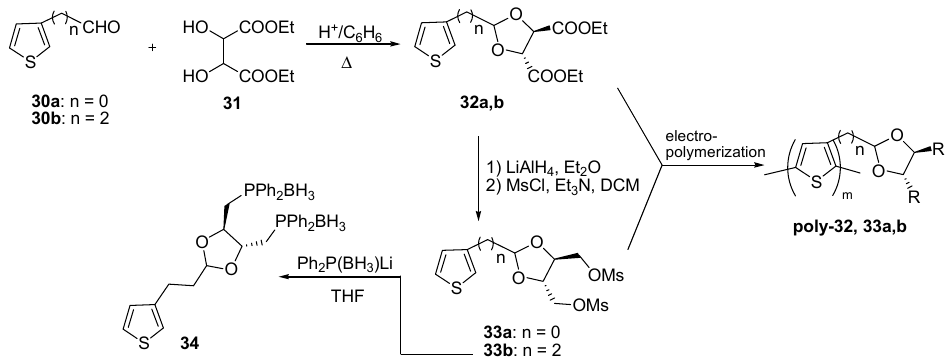
Scheme 9. Synthesis of selected 3-substituted (poly)thiophenes with a chiral 1,3-dioxalane moiety.